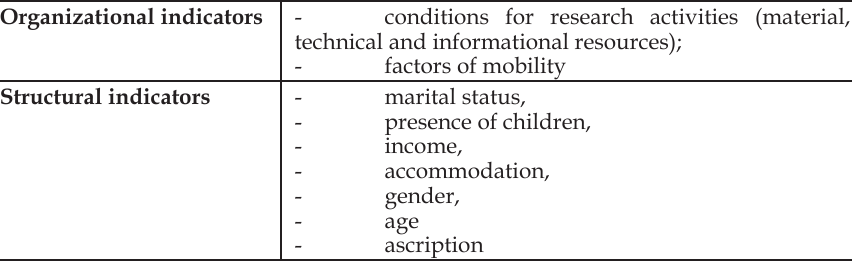
Table 1. Two lewels of the differentiating of scienti c potential. Organizational indicators